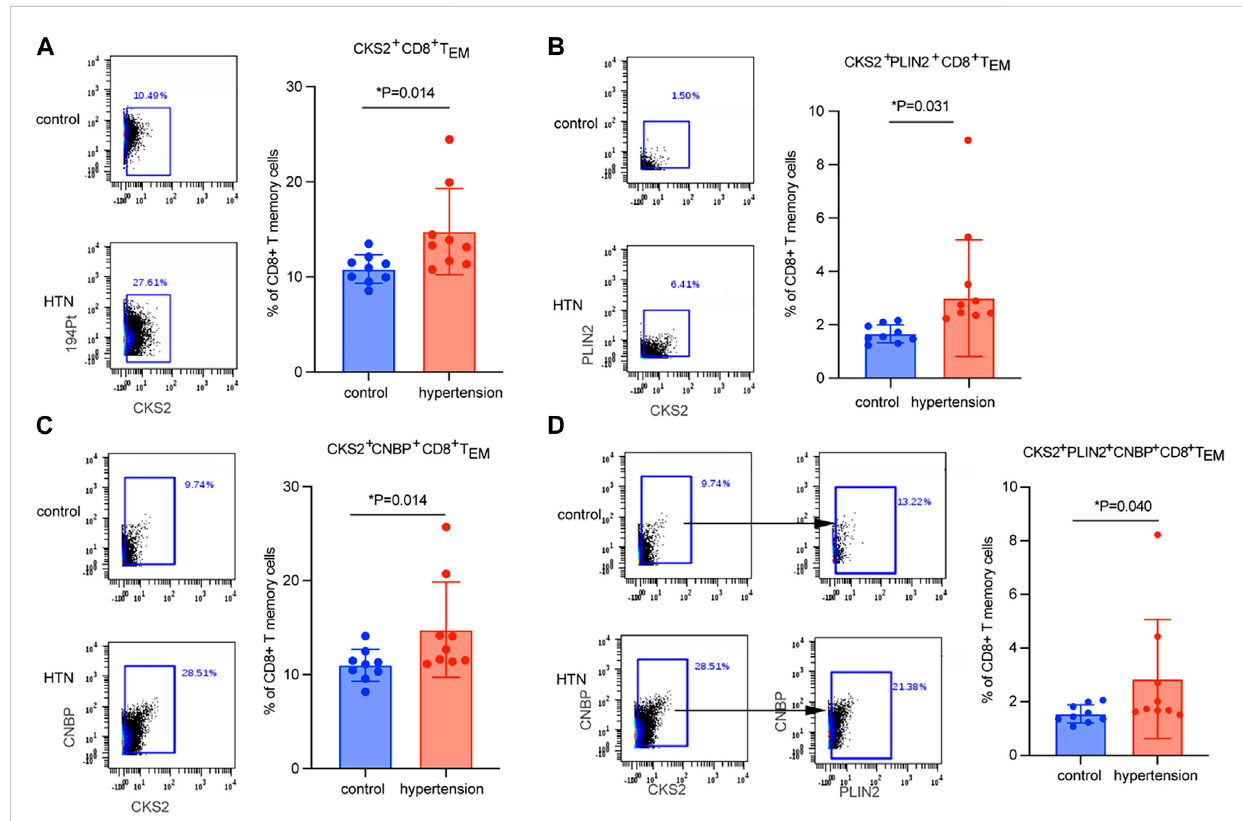
FIGURE 4 Quantitation of CD8 TEM subsets by CyTOF mass-spectrum fl ow cytometry. Quantitation of the percentage of (A) CKS2 + CD8 TEM cells, (B) CKS2 + PLIN2 + CD8TEMcells, (C) CKS2 + CNBP + CD8TEMcells,and (D) CKS2 + PLIN2 + CNBP + CD8TEMcellsbetweenhypertensivepatients(n=9)andage- matched normotensive controls (n =